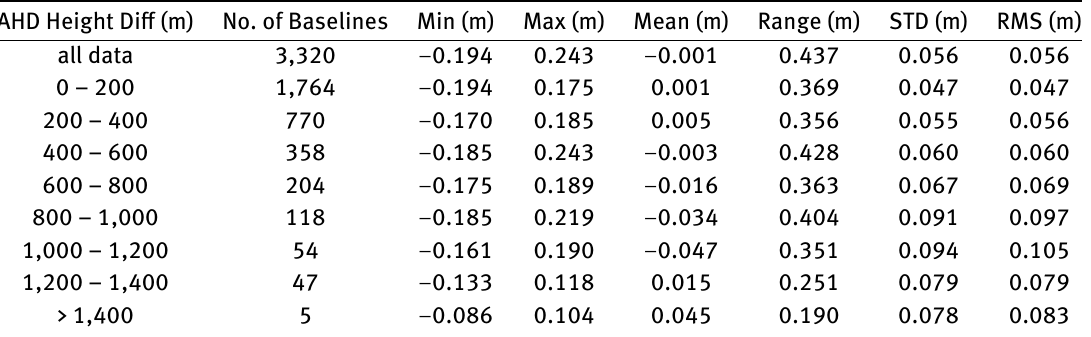
Table 1: Mid Hunter verification: Descriptive statistics of the residuals between AUSGeoid09-derived and oflcial AHD height differences as a function of AHD height difference.